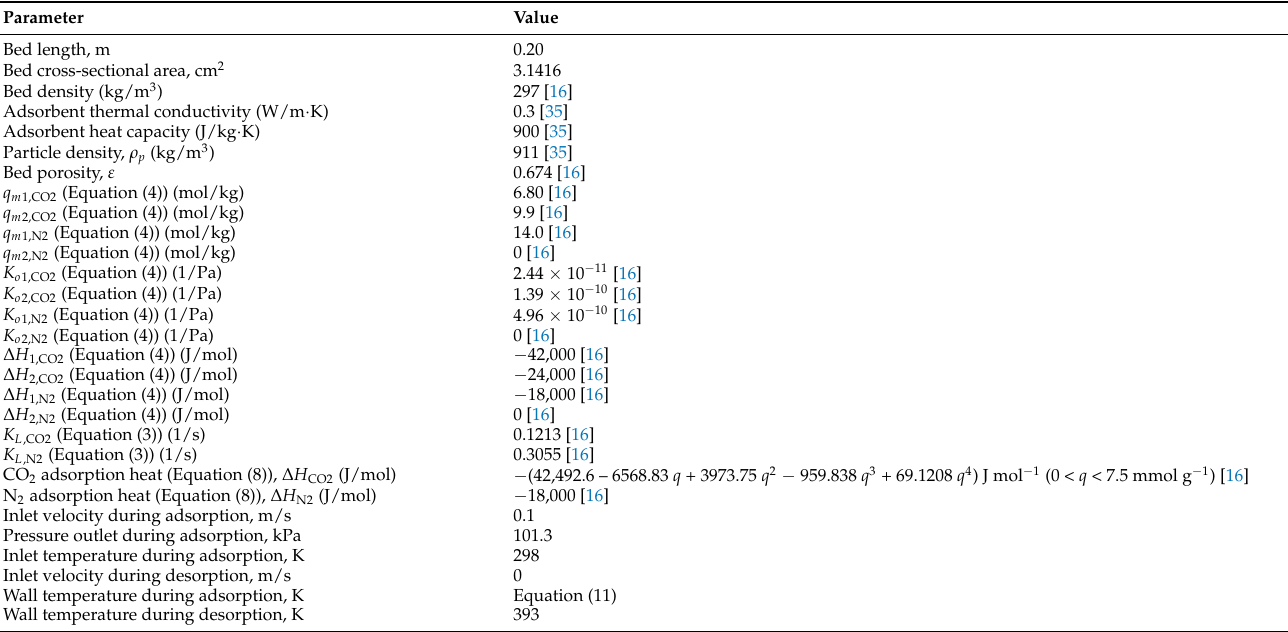
Table 1. Thermal properties, adsorbent bed construction, and applied boundary conditions.